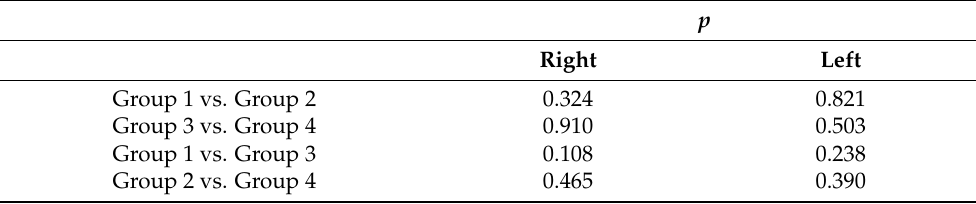
Table 3. Comparison of the movement time of erector spinae muscles between